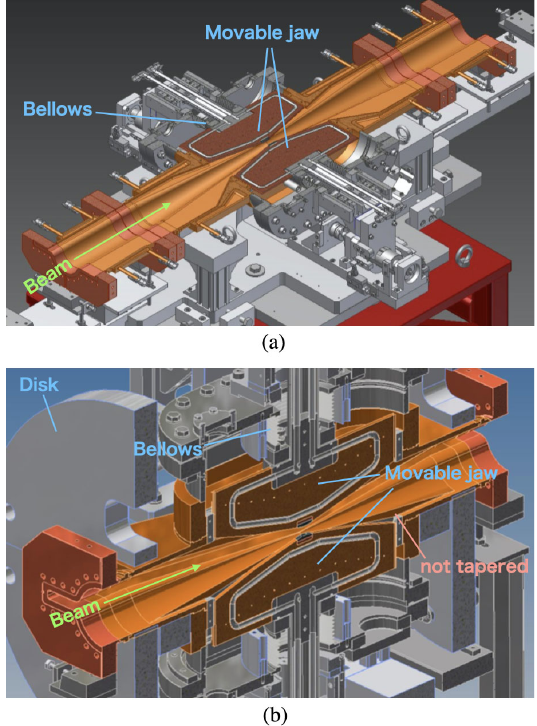
collimators.FIG. 1. Structure of (a) horizontal collimator and (b) vertical collimator.